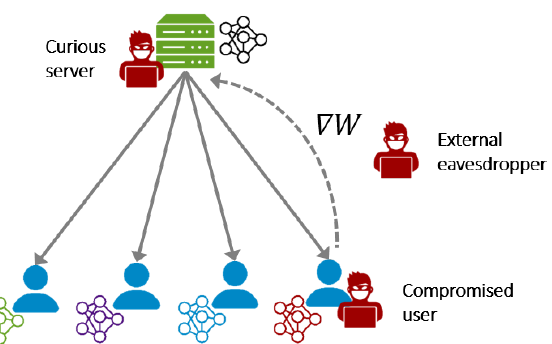
Figure 1. Federated learning overview with three potential adversary access points (in red): curious server, compromised client, and external eavesdropper. The gradients (or models updates) are generated by individual users and shared with a central server that aggregates all the gradients into a global